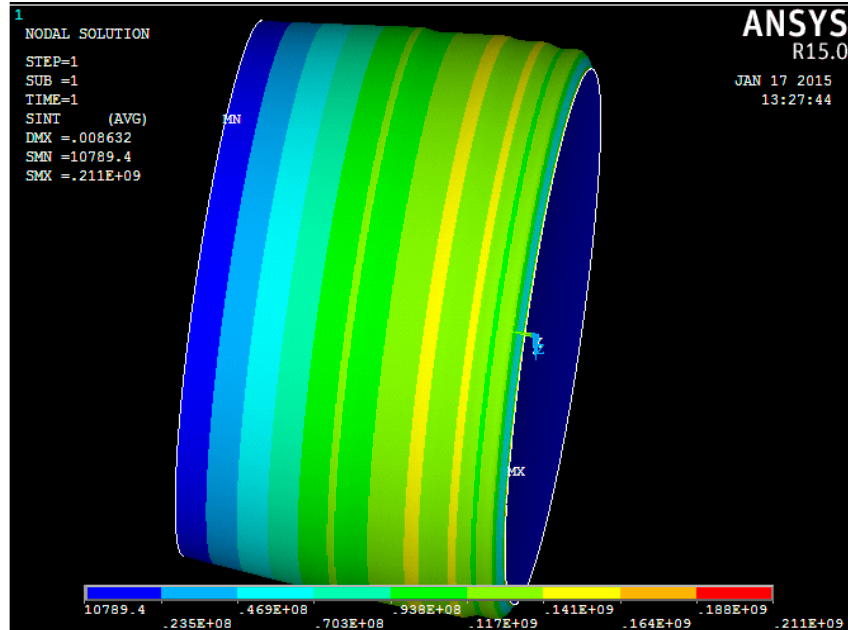
Figure 15. The results of calculating the equivalent stresses of the middle tank surface with a variable wall thickness [42].